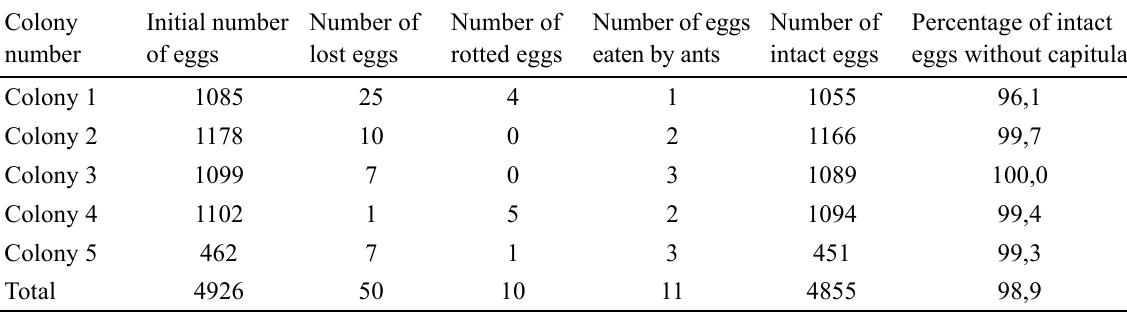
Table 1 . Capitula removal of Phraortes illepidus eggs provided for Pristomyrmex punctatus.